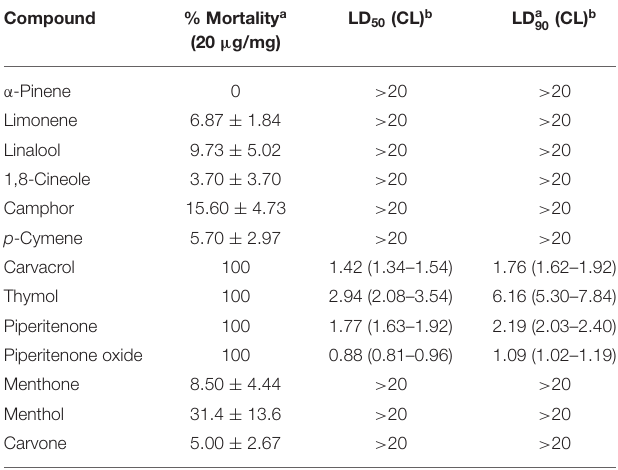
TABLE 5 | Main components of the active essential oils. Plant species Compound (% abundance)